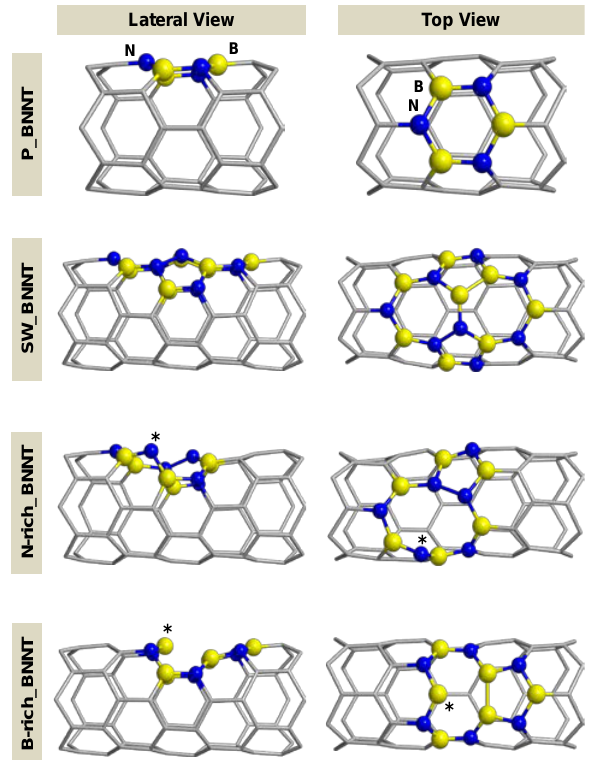
Figure 1. Lateral and top views of the different zig-zag (6,0) boron nitride nanotubes (BNNTs) used in this work: defect-free (P_BNNT); with a Stone-Wales defect (SW_BNNT); with a boron monovacancy (N-rich_BNNT); and with a nitrogen monovacancy (B-rich_BNNT). N-rich_BNNT exhibits an N atom very exposed to the BNNT wall and B-rich_BNNT a coordinatively unsaturated B atom, which are highlighted with an asterisk (see text).